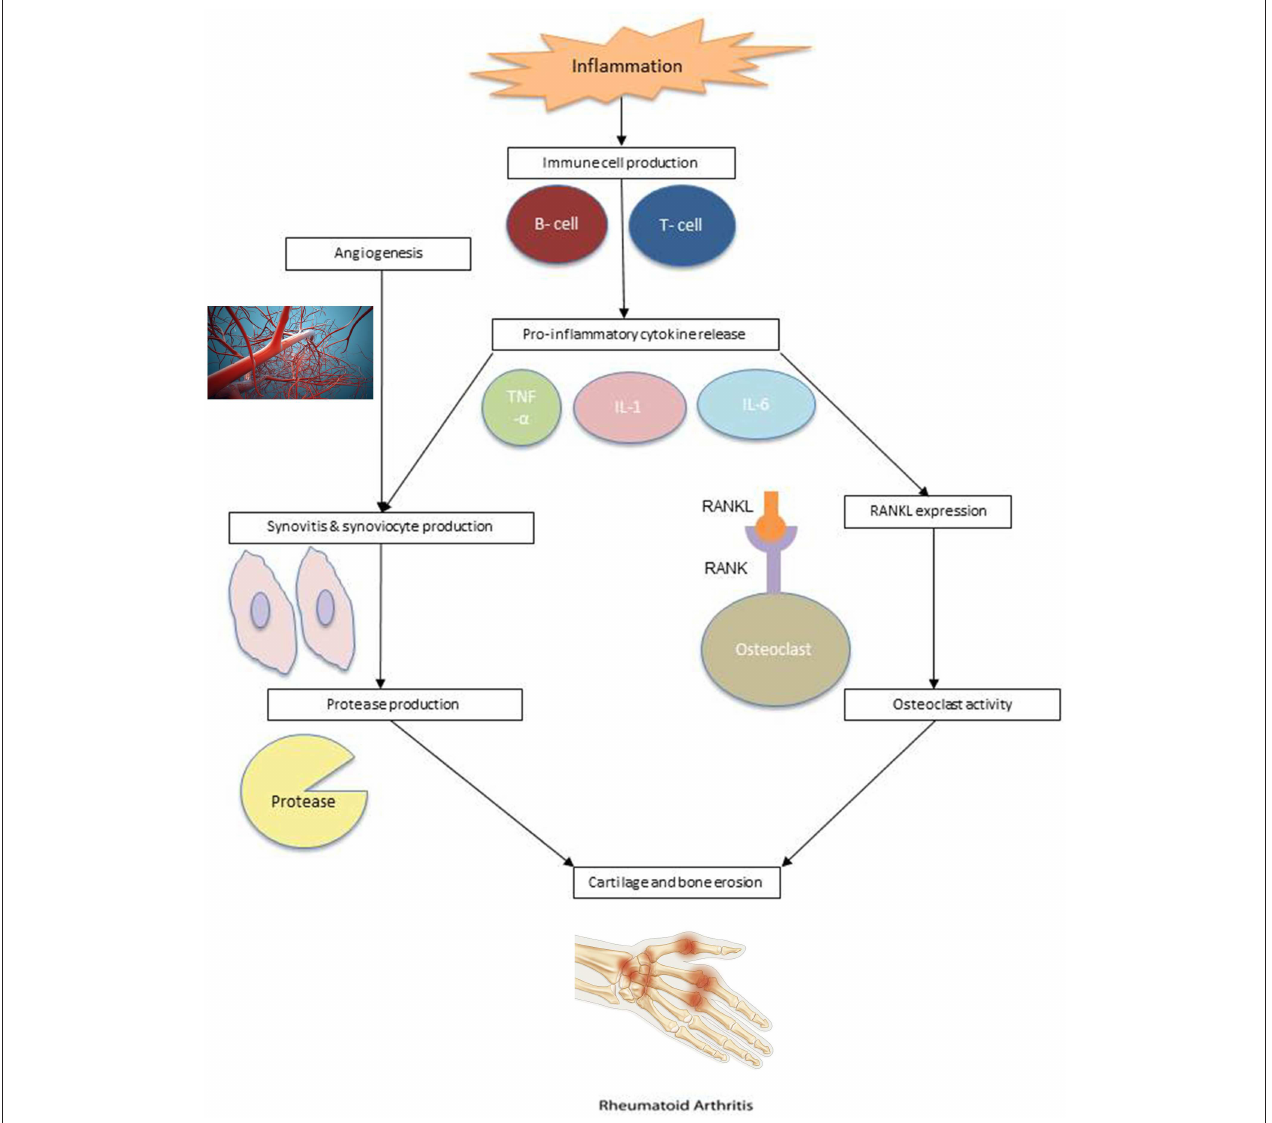
FIGURE 1 | RA pathogenesis. Angiogenesis: Reproduced from Sitox / E + via Getty Images (https://www.gettyimages.com/detail/photo/vascular-system-veins- royalty-free-image/155351346). RA Hand: Reproduced from BSIP / Universal Images Group via Getty Images (https://www.gettyimages.com/detail/news-photo/